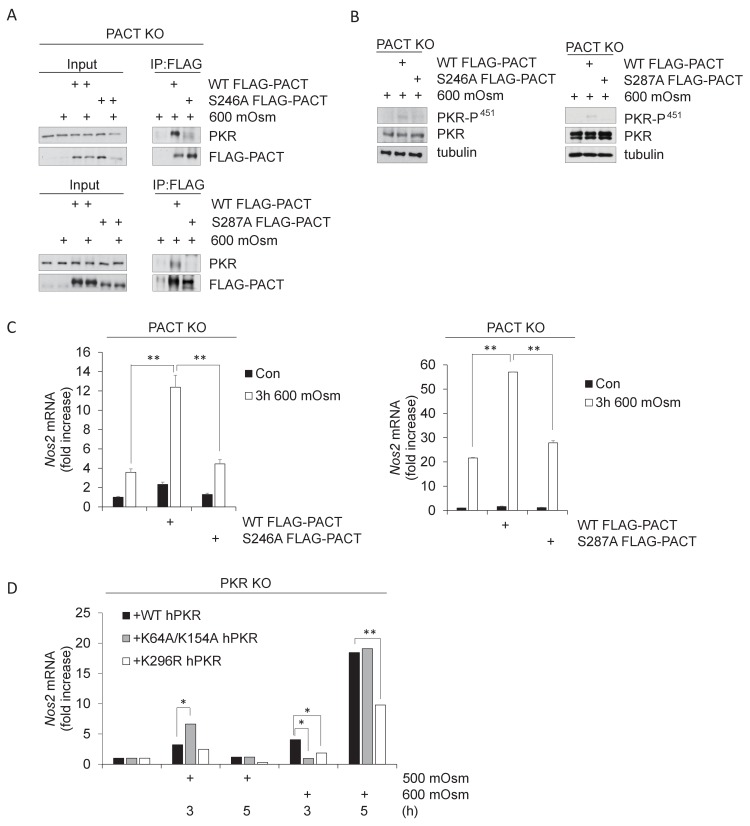
PACT Ser-246 and Ser-287 are necessary for PKR interaction and downstream inflammatory signaling.(A) PACT KO MEFs were reconstituted with FLAG-WT PACT or FLAG-S246A mutant PACT constructs, then treated with 600 mOsm sucrose for 3 hr. Proteins from total cell extracts or co-immunoprecipitated with the FLAG antibody were analyzed via western blot. (B) PACT KO MEFs were reconstituted with FLAG-WT PACT, FLAG-S246A, or FLAG-S287A mutant PACT constructs, then treated with 600 mOsm sucrose for 3 hr. Total lysates were analyzed via western blot. (C) PACT KO MEFs were reconstituted with FLAG-WT PACT or FLAG-S246A mutant PACT constructs, then treated with 600 mOsm sucrose for 3 hr. RNA was isolated, and Nos2 transcript levels were analyzed via qPCR. (D) PKR KO MEFs reconstituted with wild type PKR, PKR mutated at the RNA-binding residues (K64R/K154R), or kinase activity-deficient PKR (K296R) were treated with 500 or 600 mOsm sucrose for the indicated durations. RNA was isolated, and Nos2 transcript levels were analyzed via qPCR.